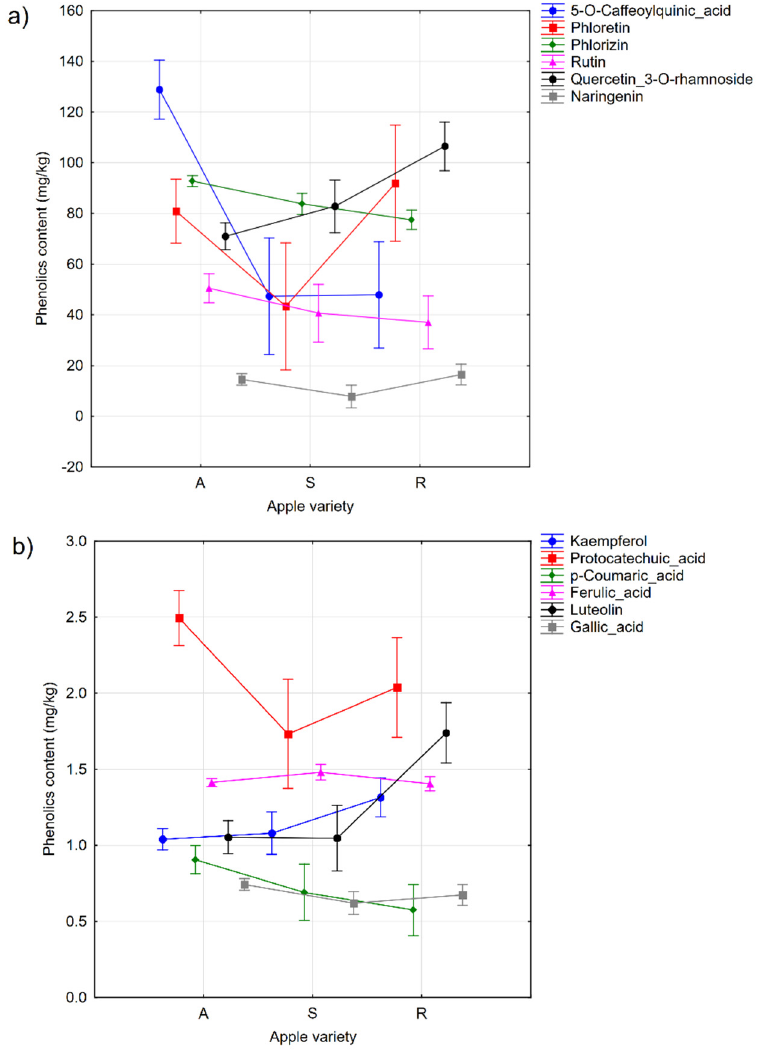
Figure 1. The plot of the MANOVA factor effects influencing the phenolic compound content in the samples. The phenolic content was plotted on the y − axis; the sort type is plotted on the x − axis: (A—autochthonous, S—standard, R—resistant). ( a ) phenolic macro components, and ( b ) phenolic micro components. Vertical bars denote 0.95 confidence intervals.